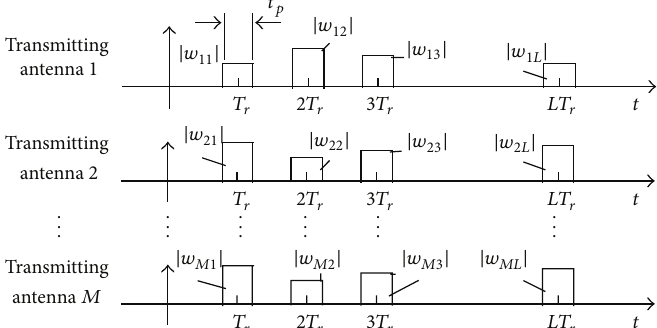
Figure 1: Illustration of space-time DOFs available.